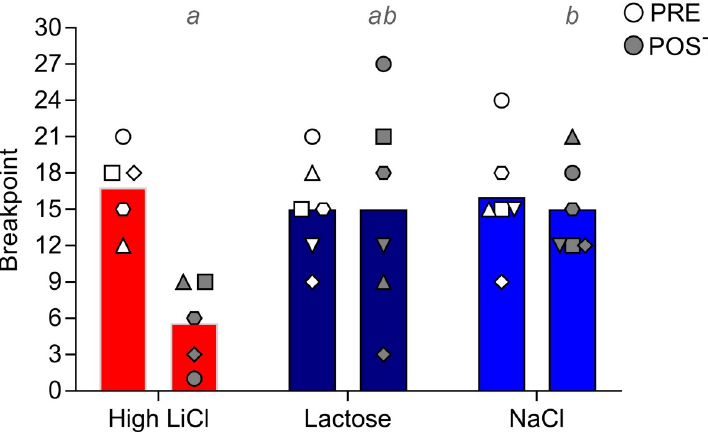
Fig 9. Filled histograms show median breakpoint for the saccharin reinforcer before and after taste-ID conditioning for the three training groups in Experiment 2. The breakpoints by the individual rats within each training group are indicated in the symbols. A given rat in each training group is represented by the same symbol across all Experiment 2 figures. Post-conditioning histograms with different gray letters were found to be significantly different from one another with post hoc Mann-Whitney U tests, Bonferroni-corrected for multiple comparisons.